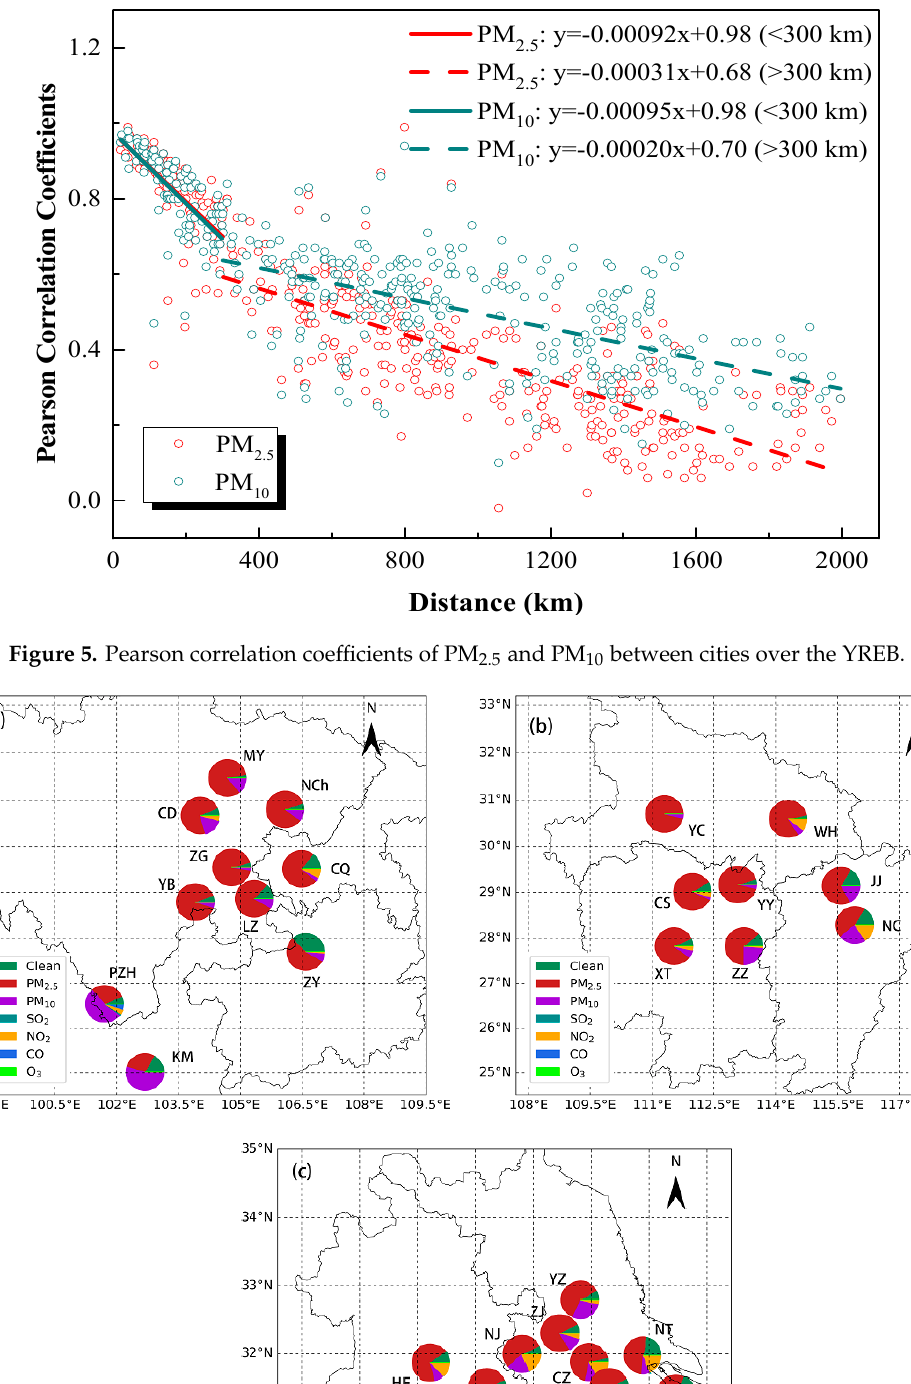
Figure 6. The proportion of major pollutants for the studied cities over the YREB ( a ) upstream, ( b ) midstream, and ( c ) downstream.